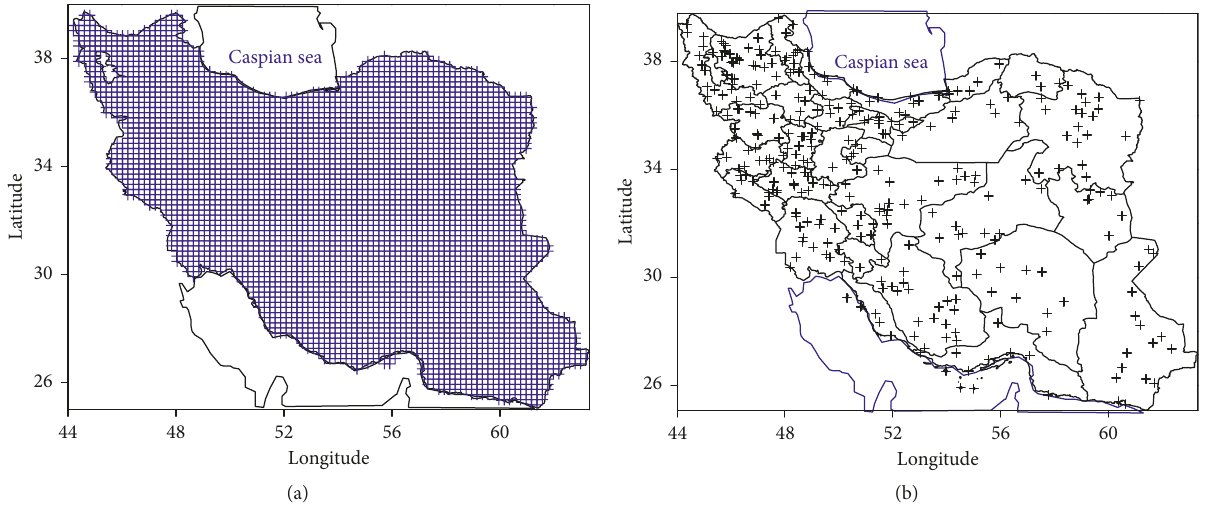
Figure 1: Regular grid of the precipitation database (a) and spatial distribution of studied stations